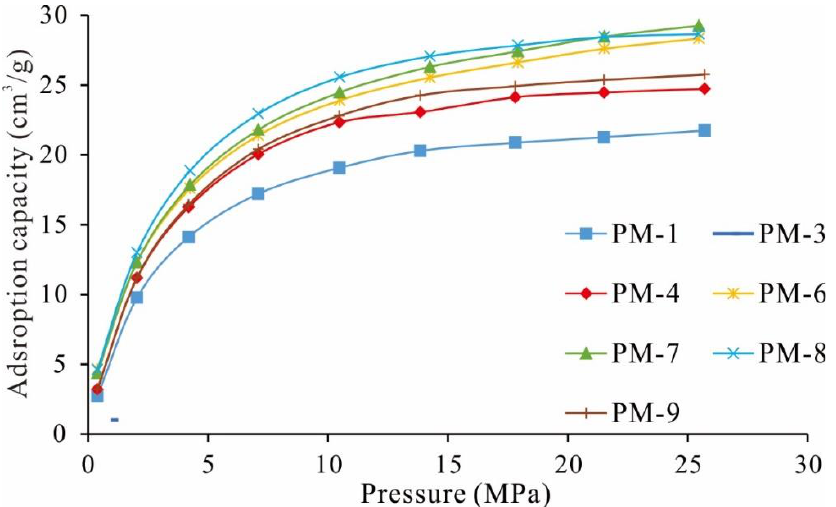
Figure 8. Isothermal adsorption curves of seven selected coal samples.